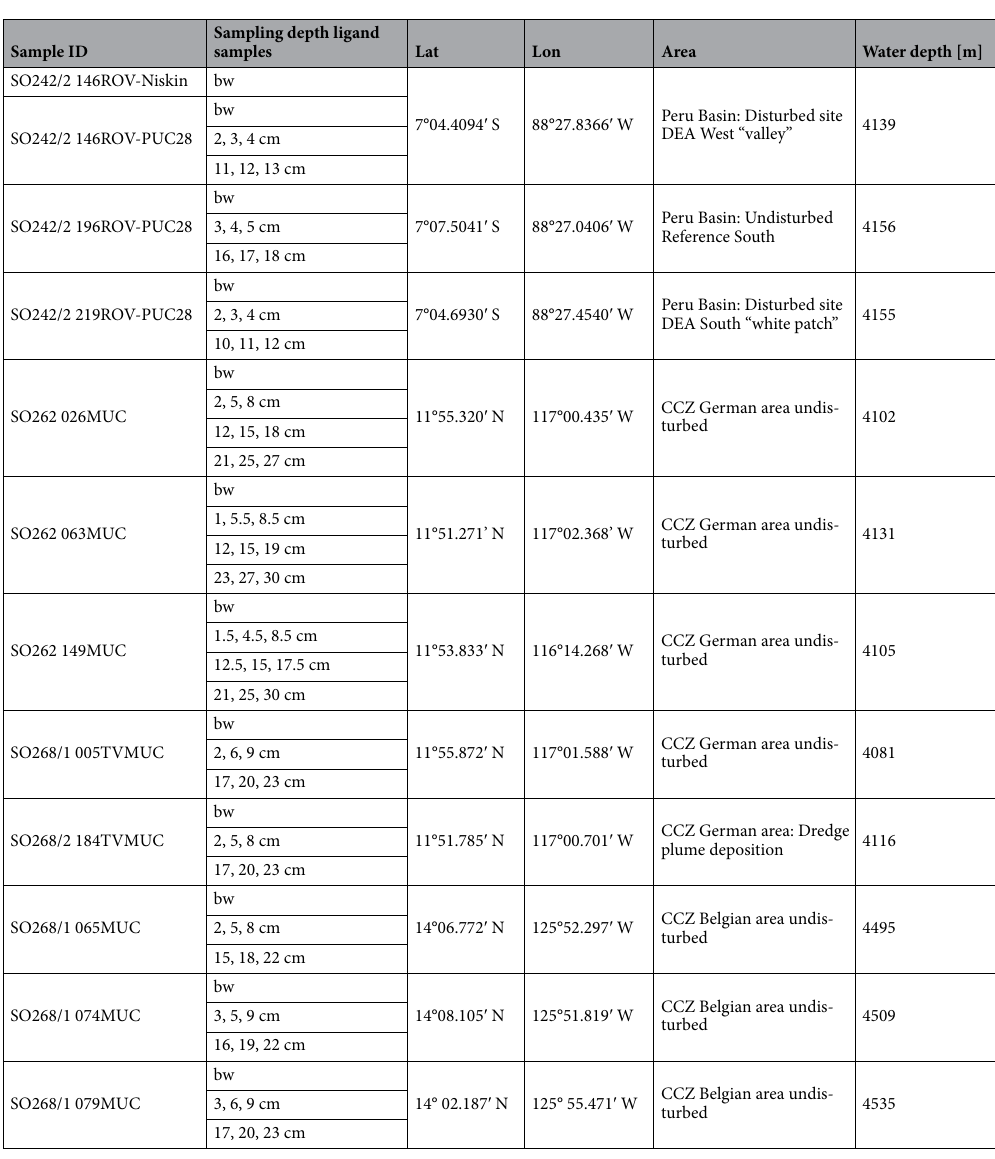
Table 1. Sample overview of sediment cores and one Niskin bottle sampled for Cu-binding L during SO242, SO262, and SO268. bw = bottom water. The three sampling depths that are given are the depths where rhizons were inserted and then pooled as one